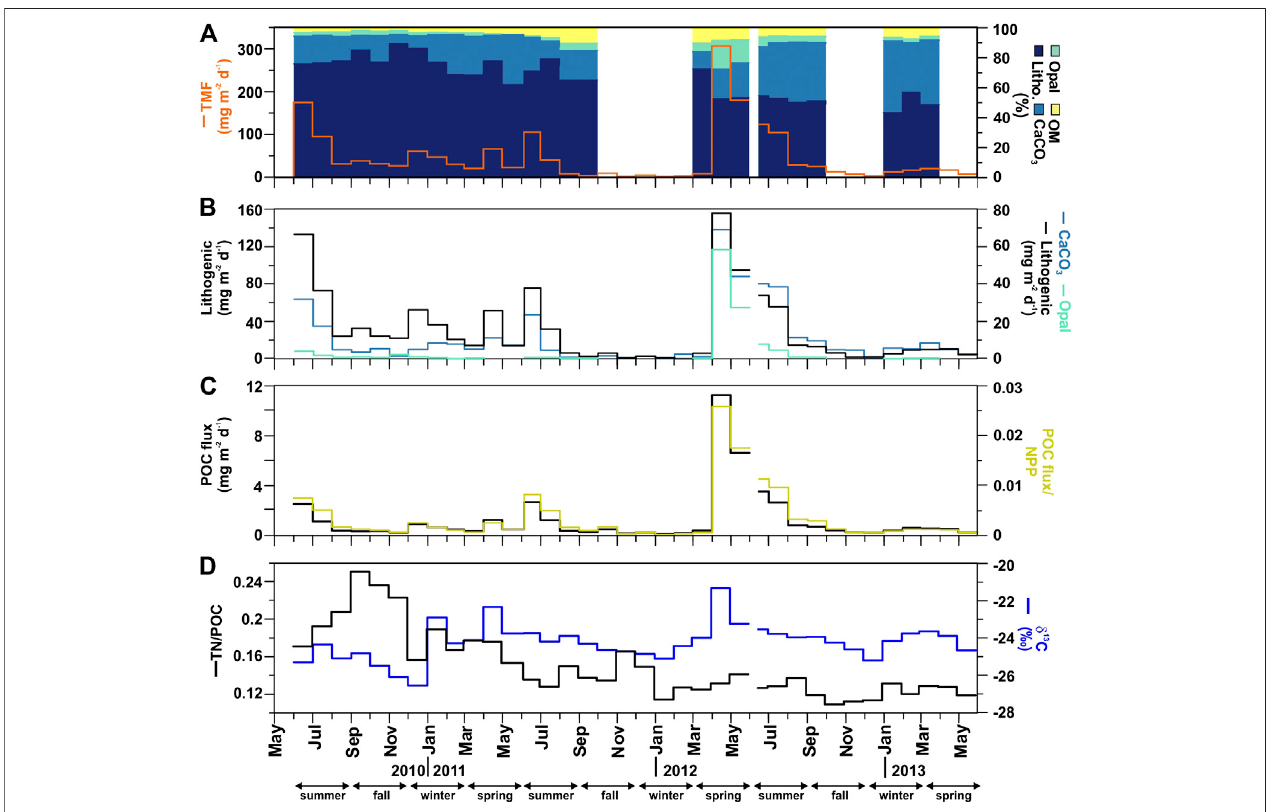
FIGURE 3 | Time-series at the Ierapetra Basin station from May 2010 to June 2013 of (A) Total Mass Flux (TMF, in mg m − 2 d − 1 ), and cumulative percentages* of organic matter (OM), opal, carbonates (CaCO 3 ) and lithogenic; (B) Fluxes oflithogenic,opal and CaCO 3 ; (C) Particulate organic carbon (POC) fl ux, and export ef fi ciency ratio (POC fl ux/NPP); (D) TN/POC molar ratio and δ 13 C stable isotope (*Gaps of cumulative percentages of fl ux components correspond to periods where there are no opal data